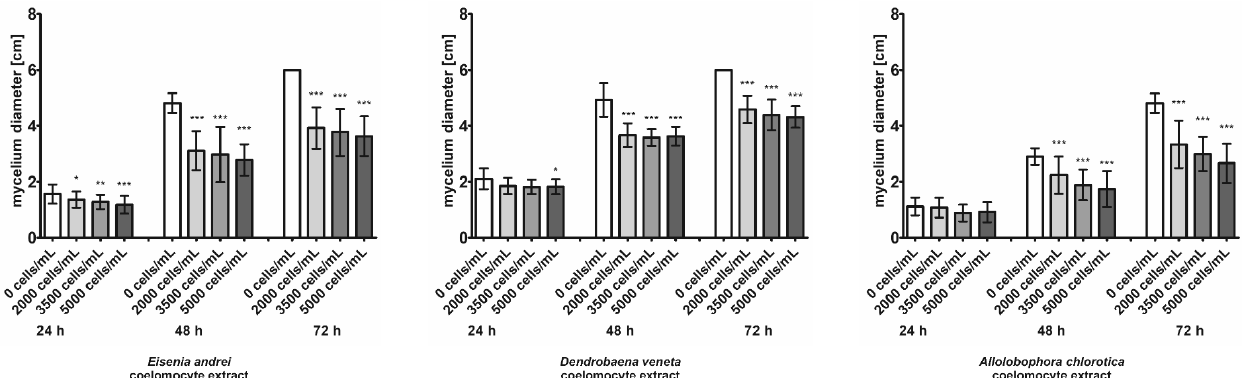
Figure 4. Growth (mean diameter ± SD) of Macrophomina phaseolina mycelium 24, 48 and 72 h after treatment with Eisenia andrei , Dendrobaena veneta and Allolobophora chlorotica coelomic fluid extracts. Significant differences between control and groups treated with coelomocyte extracts are labeled with * ( p < 0.05), ** ( p < 0.01) and *** ( p <